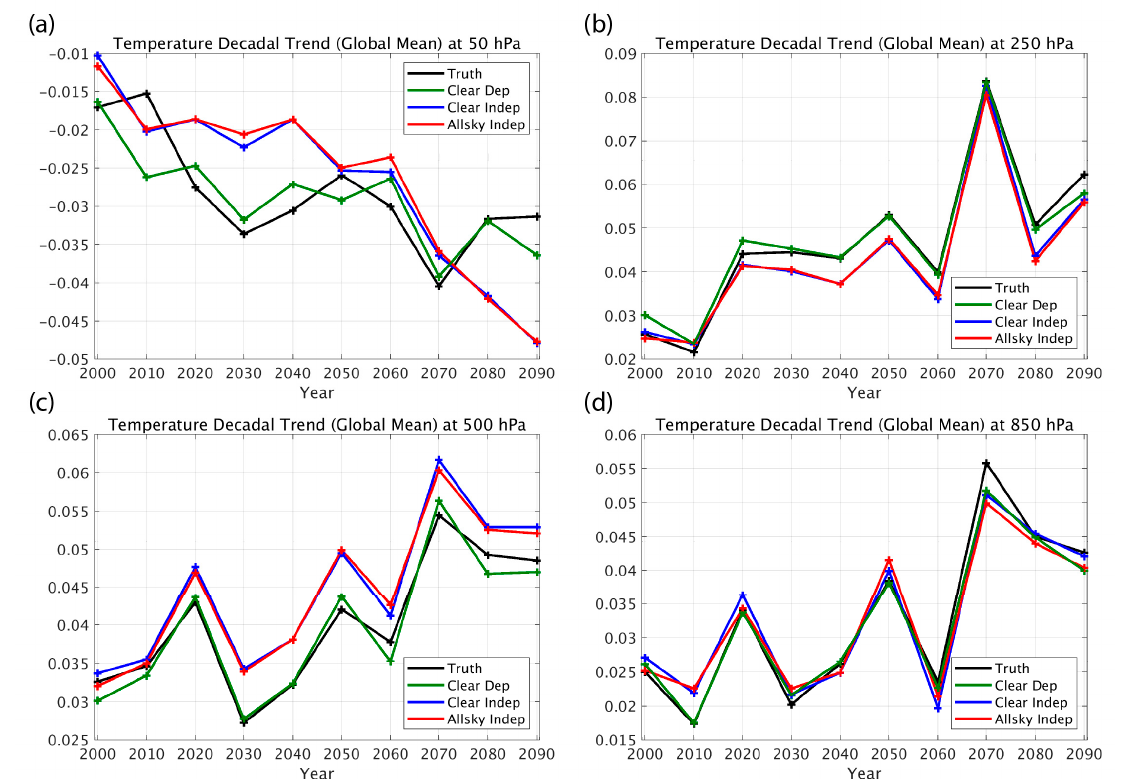
Figure 2. Examples of comparisons between decadal trends (K/year) produced by a 100 ‐ year climate model simulation for four atmospheric levels: (a) 50 hPa, (b) 250 hPa, (c) 500 hPa, (d) 850 hPa. The “Truth” (black curve) decadal trends throughout the twenty ‐ first century are compared with those retrieved from simulated hyperspectral infrared radiance measurements, assuming: clear ‐ sky conditions using a linear regression model trained with the climate model ‐ produced atmospheric conditions (Clear Dep, green curve); clear ‐ sky conditions using a linear regression model trained with contemporary global weather observation atmospheric conditions (Clear Indep, blue curve); and all ‐ sky conditions using a linear regression model trained with contemporary global weather observation atmospheric conditions (All ‐ sky Indep, red curve).